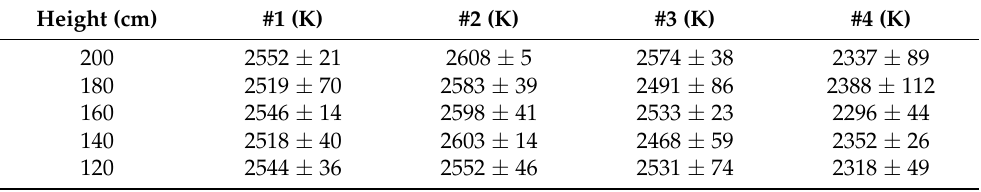
Table 10. The average temperature and standard deviation of the flame of the four samples at different drop